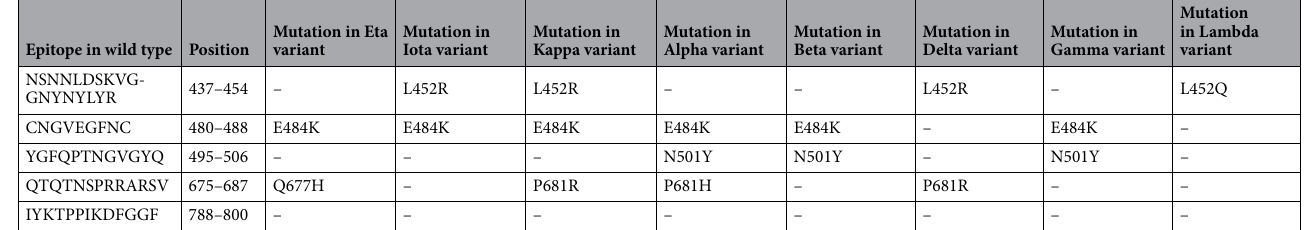
Table 2. Selected Epitopes and mutations in emerging